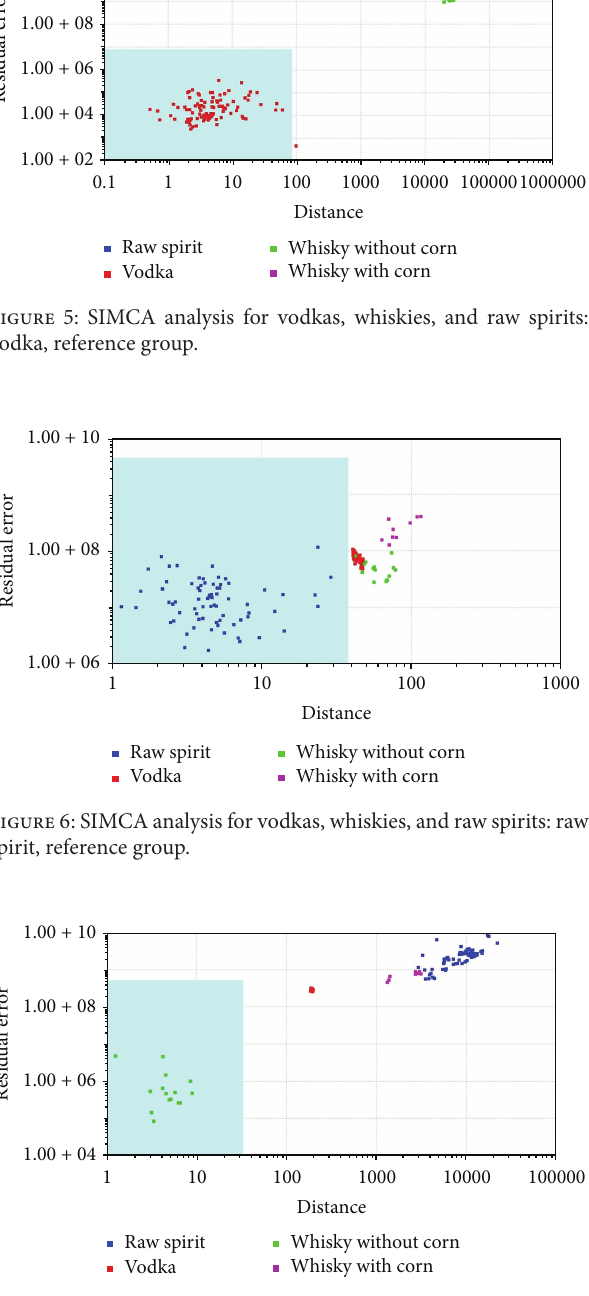
Figure 7: SIMCA analysis for vodkas, whiskies, and raw spirits: whisky without corn, reference group.